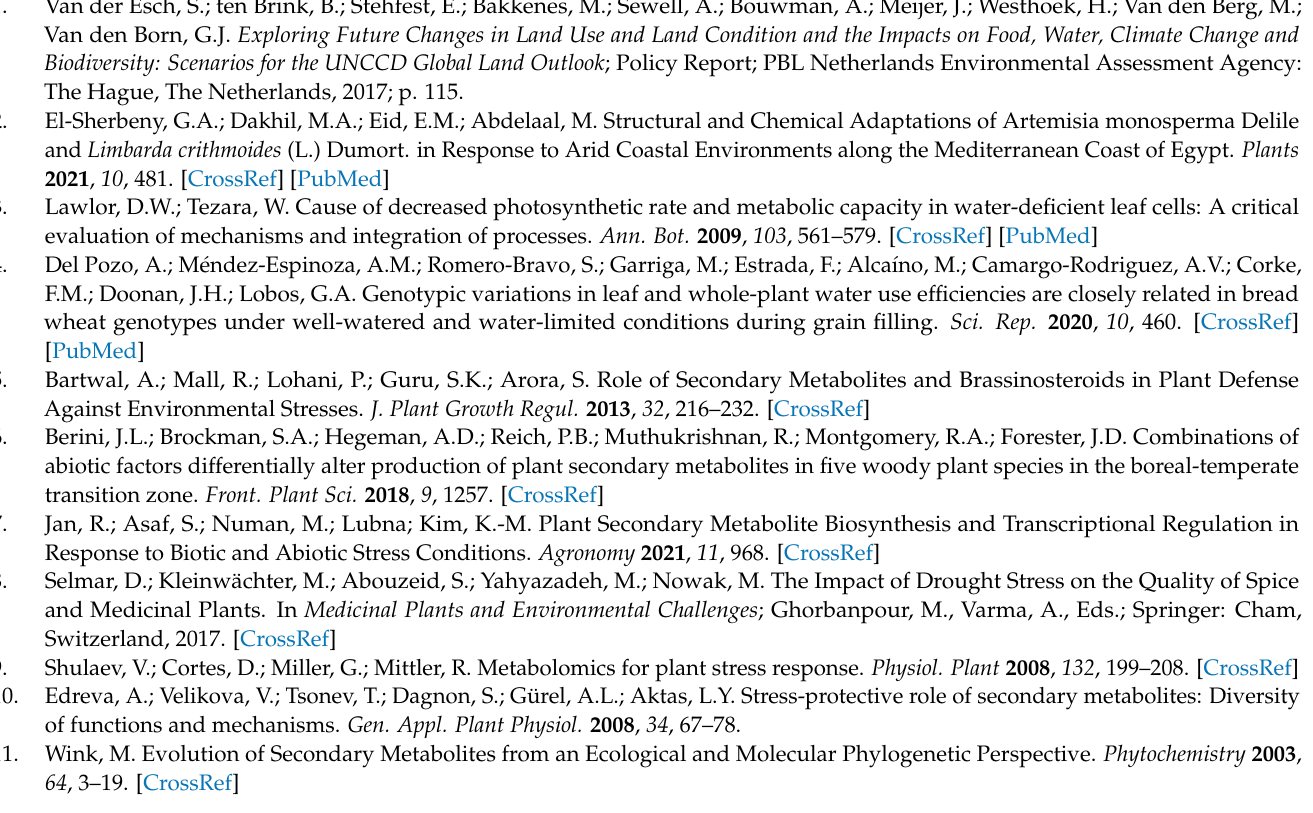
Table S2: Change in content of SM in root under stress